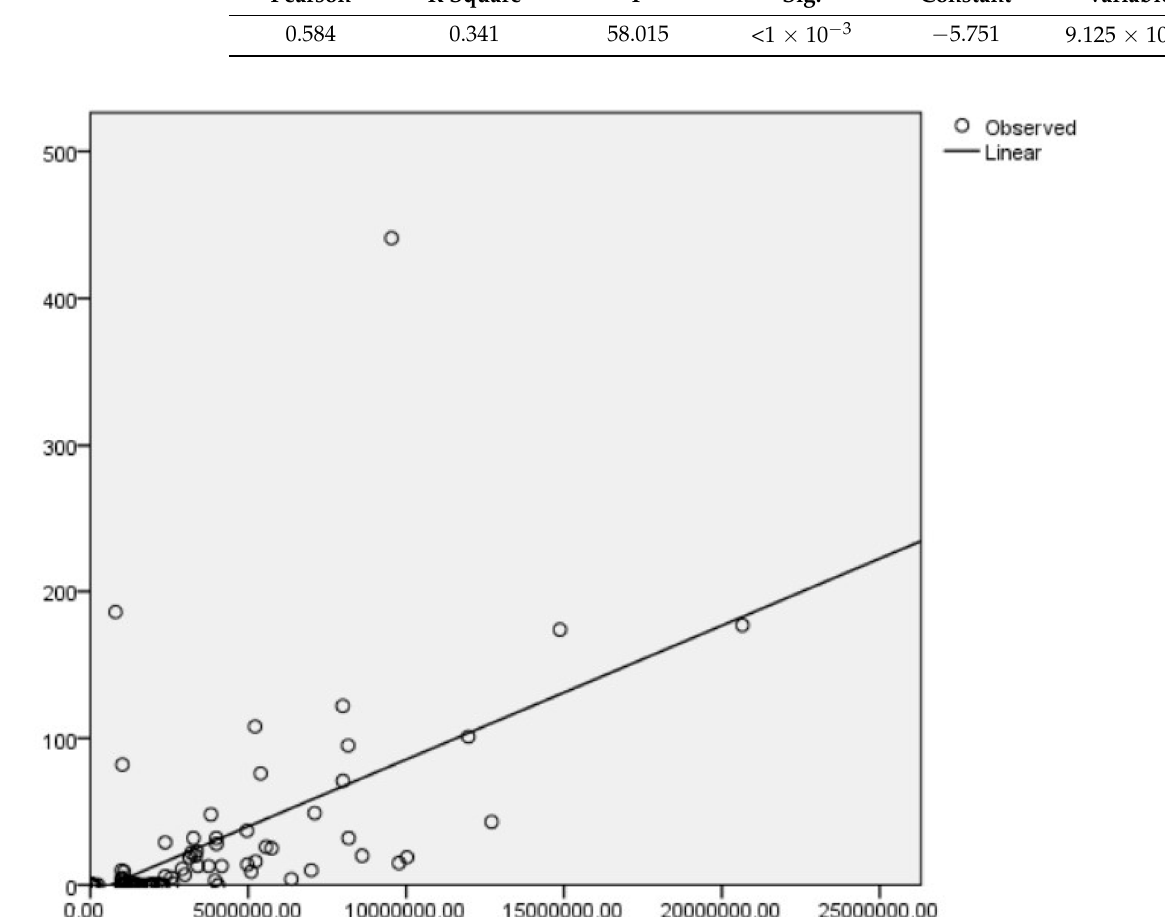
Figure 7. Linear regression model between funding and number of publications.